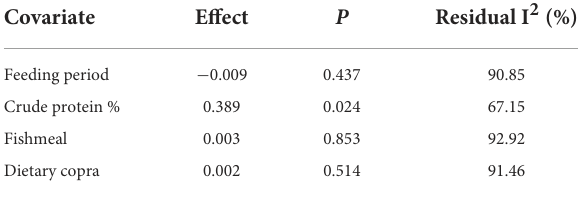
TABLE 8 Meta-regression for moisture composition.